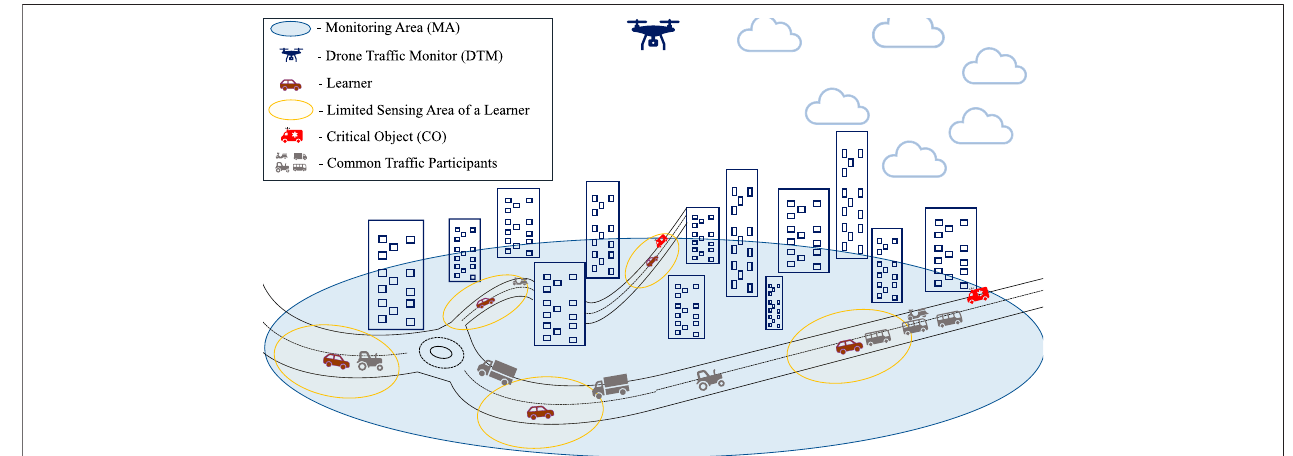
FIGURE 1 | Illustration of the DTM covered monitoring area, with fi ve scattered learners.